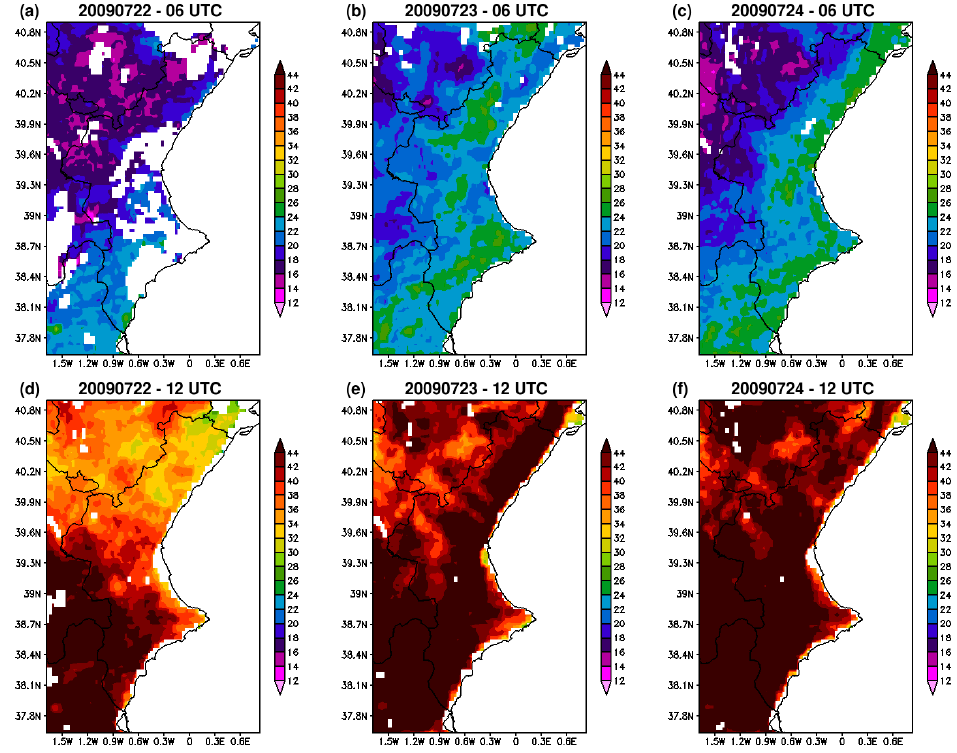
Figure 2. MSG-SEVIRI LST at 06 UTC on 22 July ( a ); 23 July ( b ) and 24 July 2009 ( c ); and at 12 UTC on 22 July ( d ); 23 July ( e ) and 24 July 2009 ( f ).